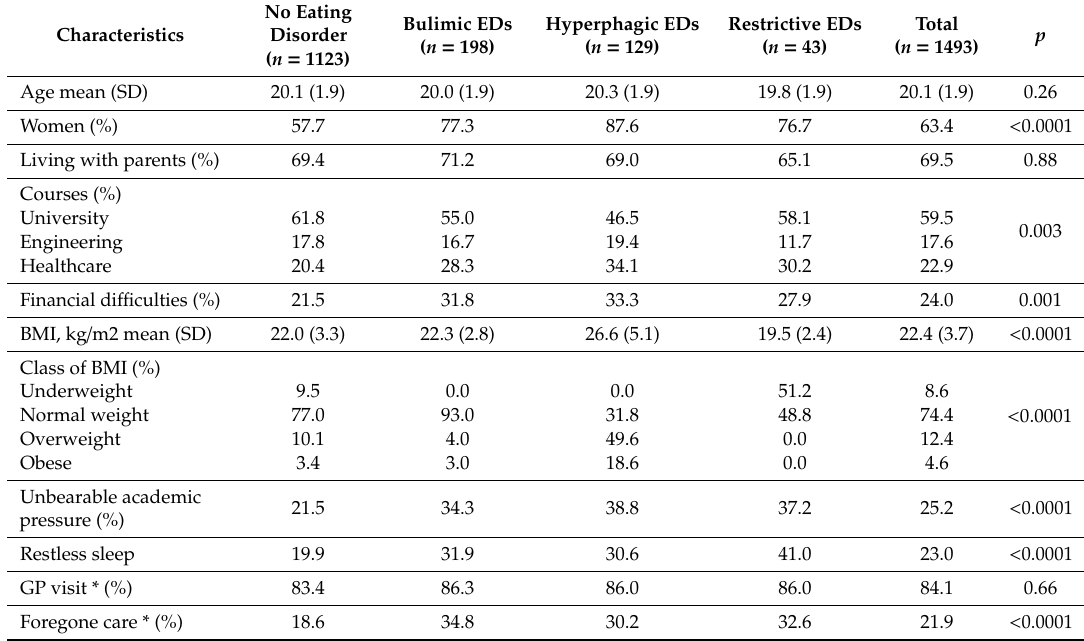
Table 1. Characteristics of students according to their eating disorder diagnostic category.